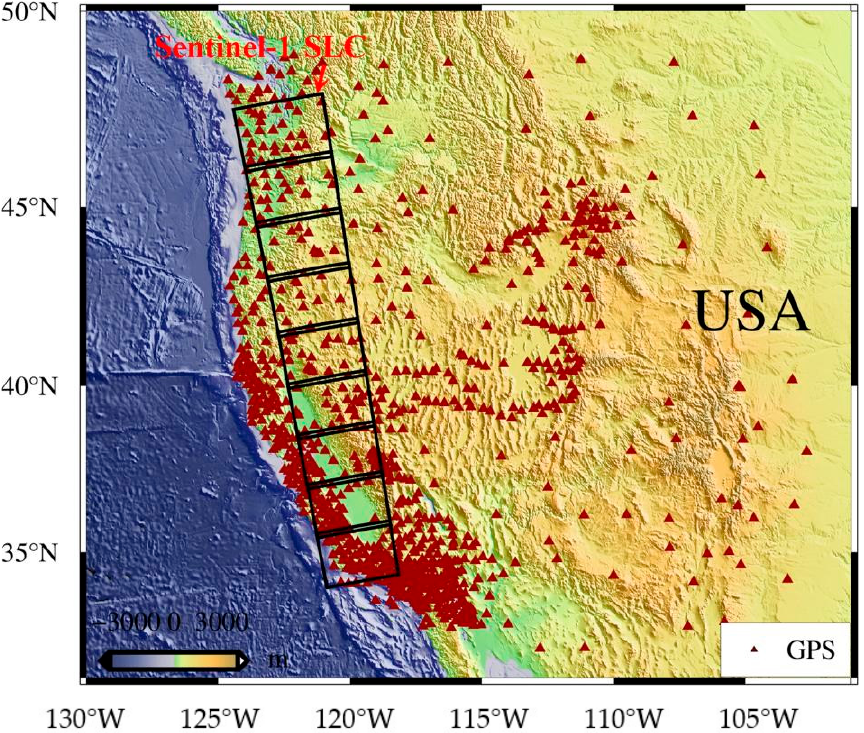
Figure 2. Distribution of 1038 continuous GPS sites and multiple Sentinel-1 SLC image ranges on the west coast of the